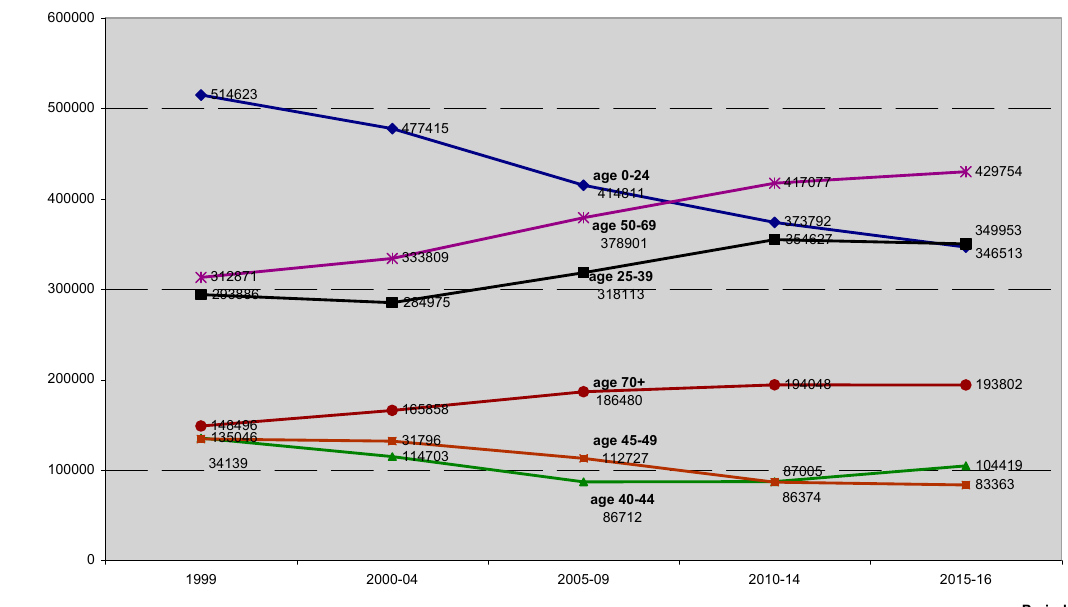
Figure 2. Changes in the average annual number of women in Lower Silesian voivodeship in the analyzed age groups according to the studied periods.